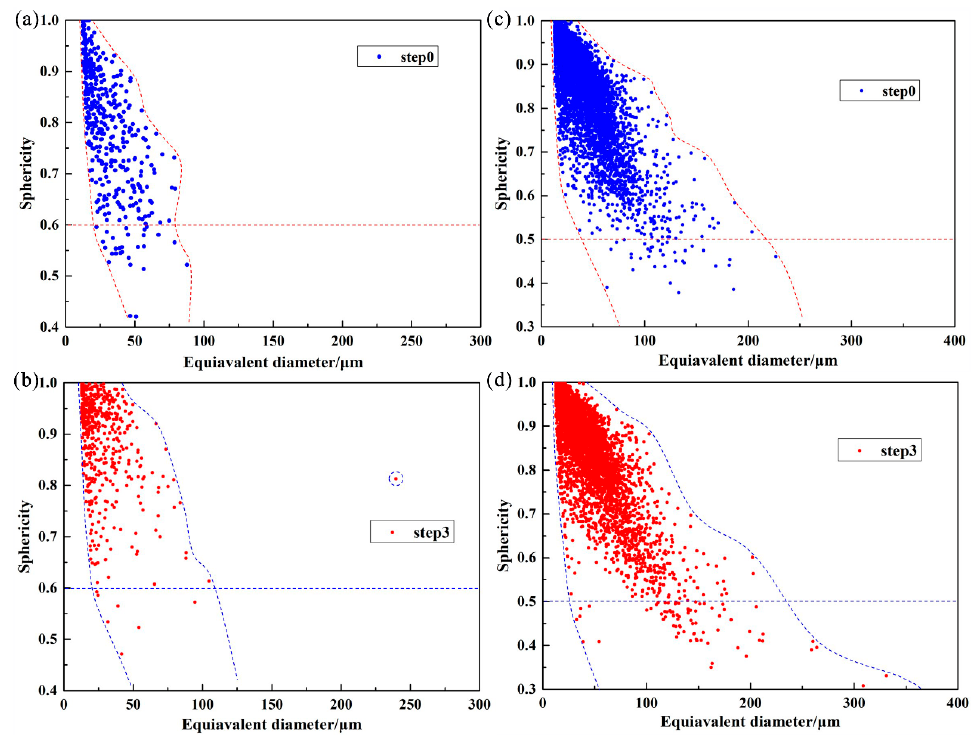
Figure 8. The relationships between equivalent diameter d and sphericity S for: ( a ) Specimen 400 at step0, ( b ) Specimen 400 at step3, ( c ) Specimen 1000 at step0, and ( d ) Specimen 1000 at step3.